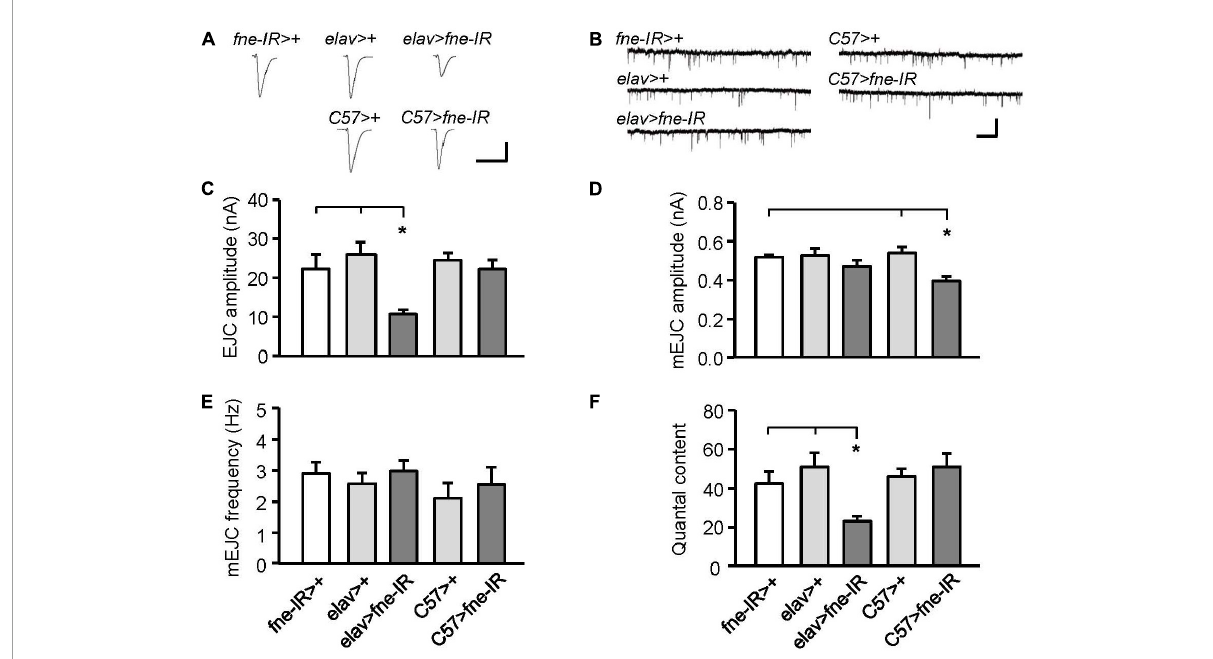
FIGURE3 Knockdown of fne in neurons and muscle cells altered synaptic transmission in the larval NMJ. (A) Representative traces of EJC in the indicated genotypes. Calibration: 10 nA, 50 ms. (B) Representative traces of mEJC in the indicated genotypes. Calibration: 1 nA, 1 s. Quantification of